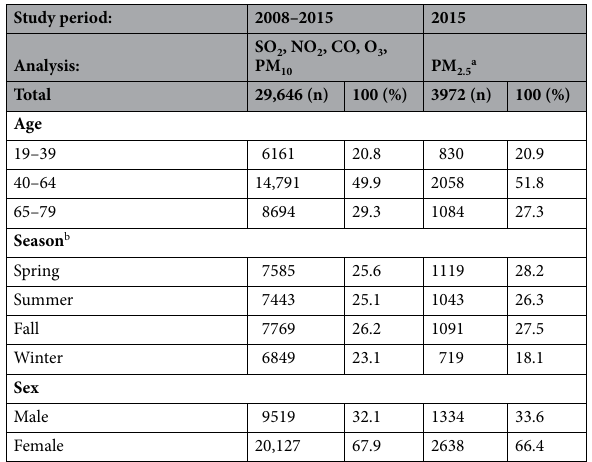
Table 1. Characteristics of 29,646 Meniere’s disease cases according to subgroups in Korea between 2008 and 2015. a In subgroup analysis for PM 2.5 , regions (Daejeon, Ulsan, Jeonbuk, Jeju, Chungnam, and Chungbuk) with fewer than 20 cases in the subgroup were excluded. b Definitions for seasons are as follows: Spring